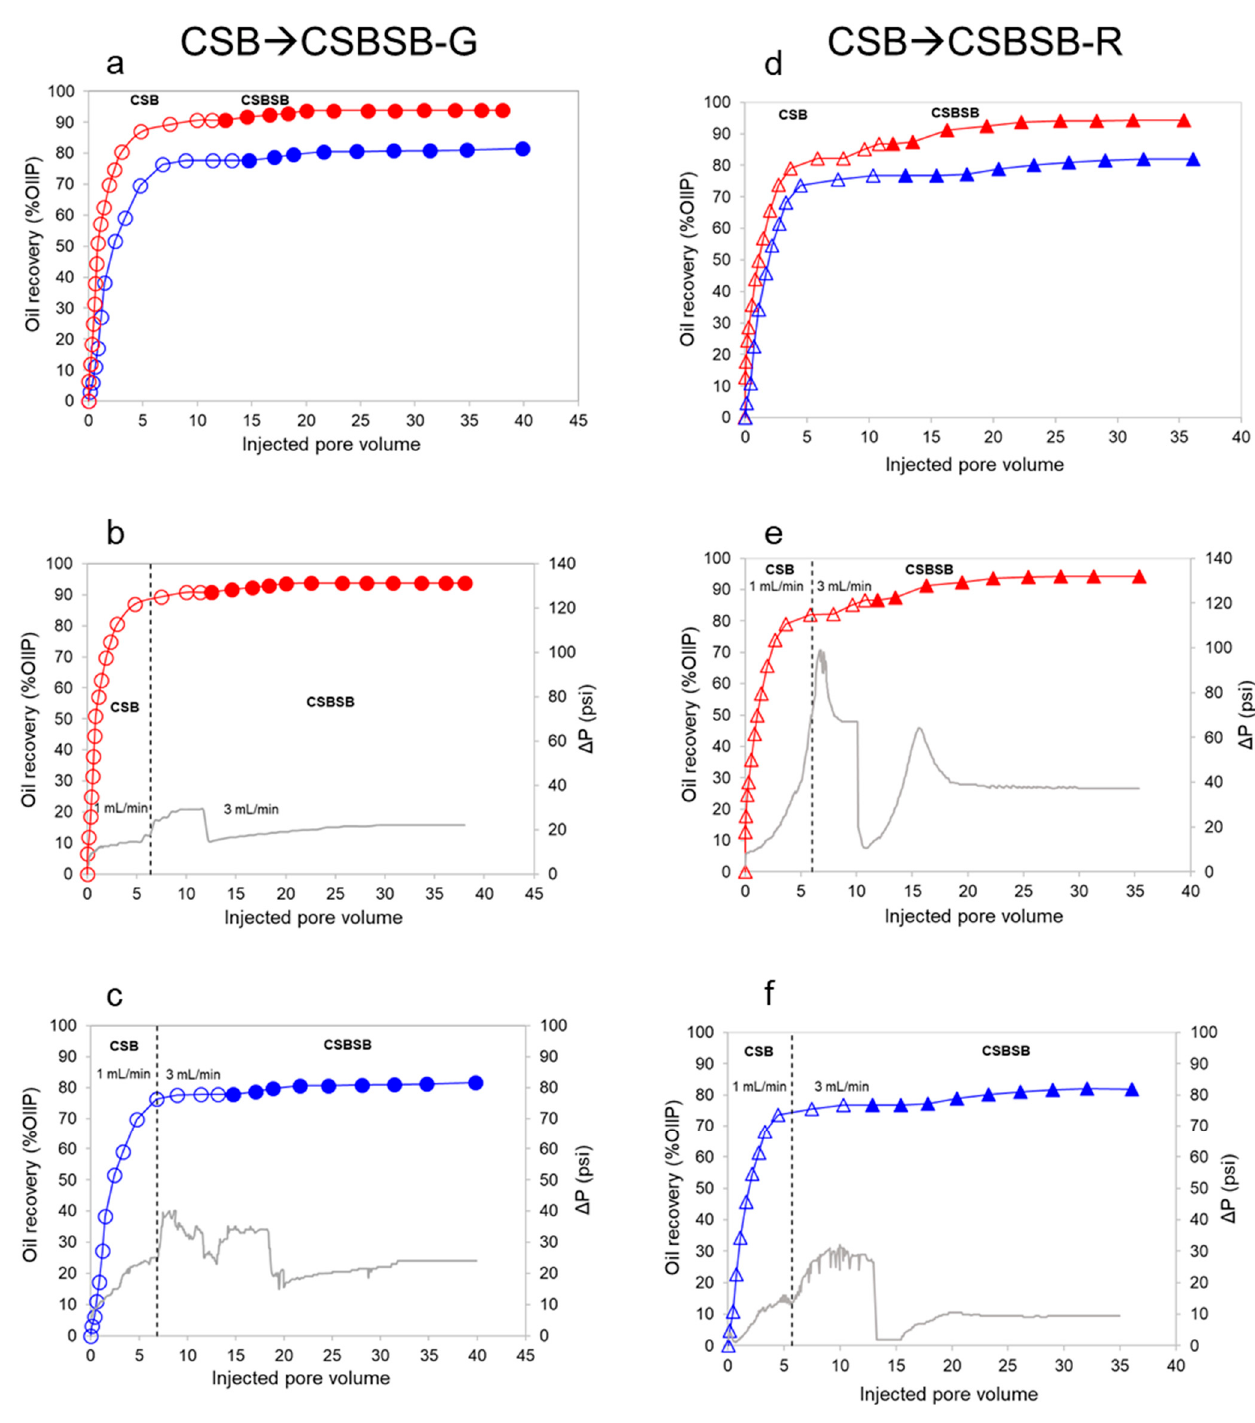
Figure 4. Oil recovery during secondary injection of CSB and tertiary injection of CSBSB. Red hollow and filled circles ( a , b ) correspond to the applications of CSB and GreenZyme ® (CSBSB-G) in secondary and tertiary flooding respectively carried out at 70 °C on rock sample C11 with initial water saturation of S wi = 0.45, while blue circles ( a , c ) correspond to the experiments at 23 °C on rock sample C09 with S wi = 0.42. Red hollow and filled triangles ( d , e ) correspond to the applications of CSB and rhamnolipid (CSBSB-R) in secondary and tertiary flooding respectively carried out at 70 °C on sample C20 at S wi = 0.45, while blue triangles ( d , f ) represent the results obtained with C17 at 23 °C and with S wi = 0.45. Grey curves show the measured pressure difference across the samples and vertical dashed lines indicate a transition from the injection rate of 1 mL/min to 3 mL/min.